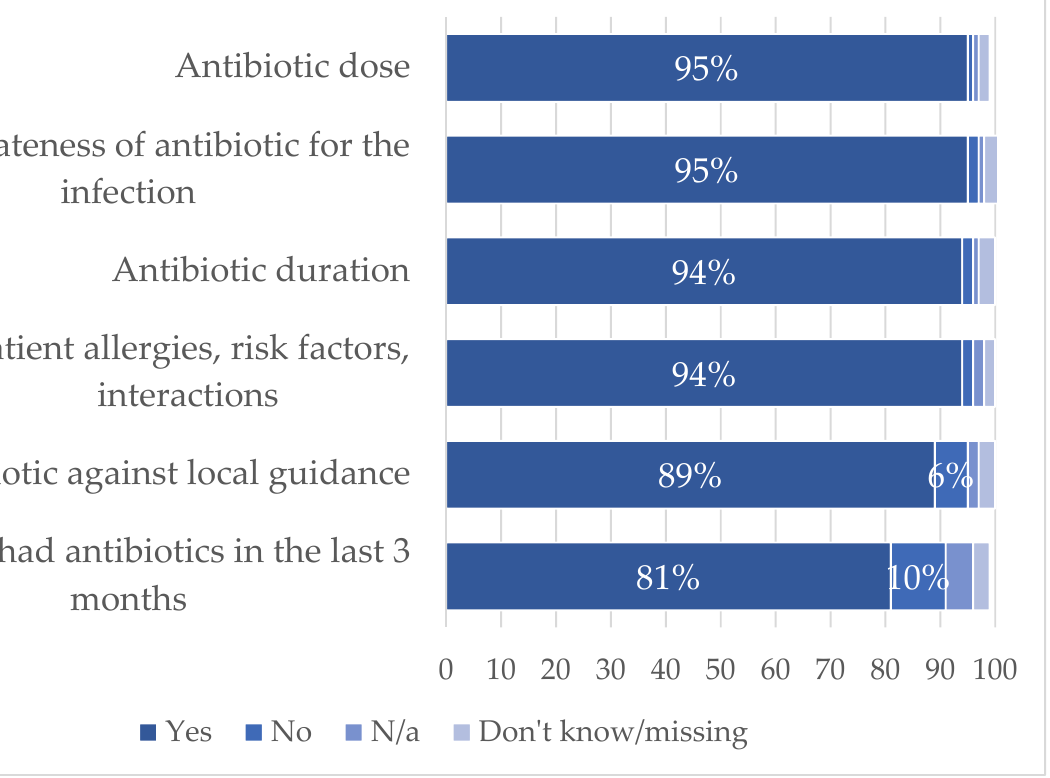
Figure 2. Proportion of antibiotic safety checks completed by the pharmacist or pharmacy team, prompted by the Antibiotic Checklist for 212,124 prescriptions.